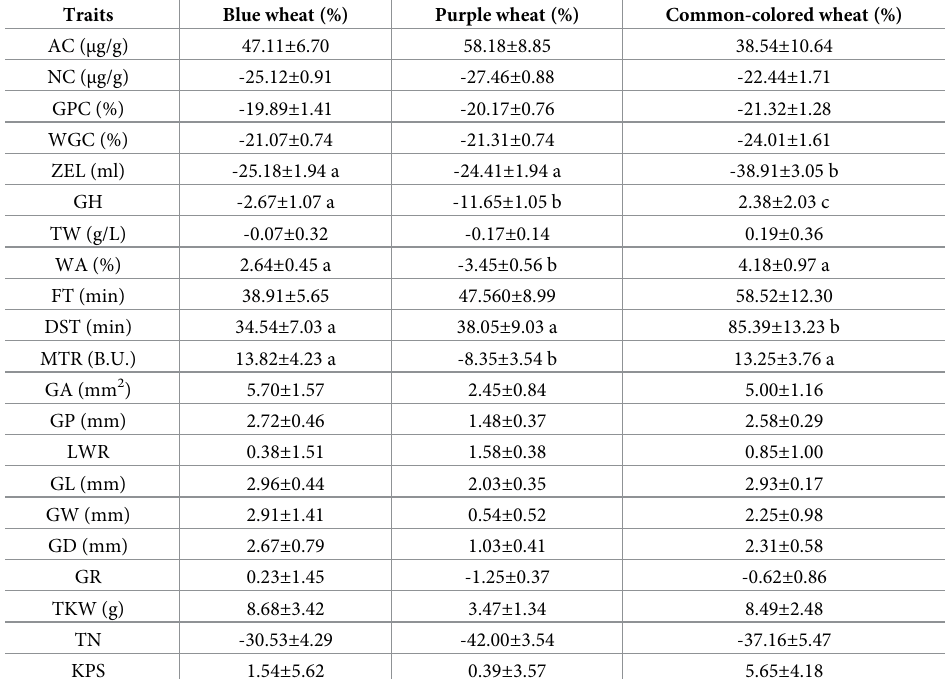
Table 4. Performance variation proportion under LN stress of those under HN conditions.